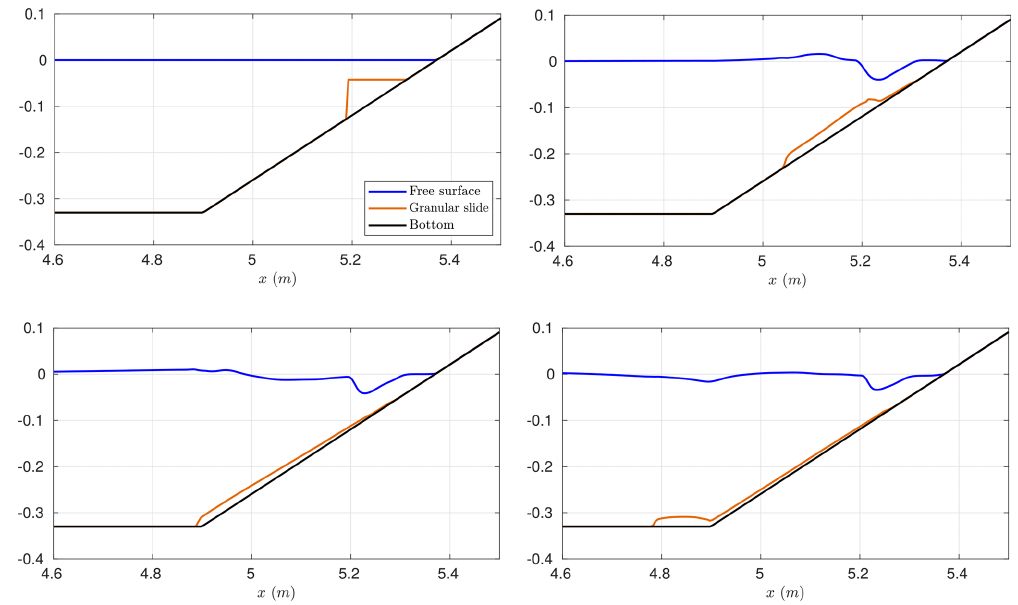
Figure 4. Modeled location of the granular material and water free surface elevation at times t = 0, 0.3, 0.6, and 0.9s.